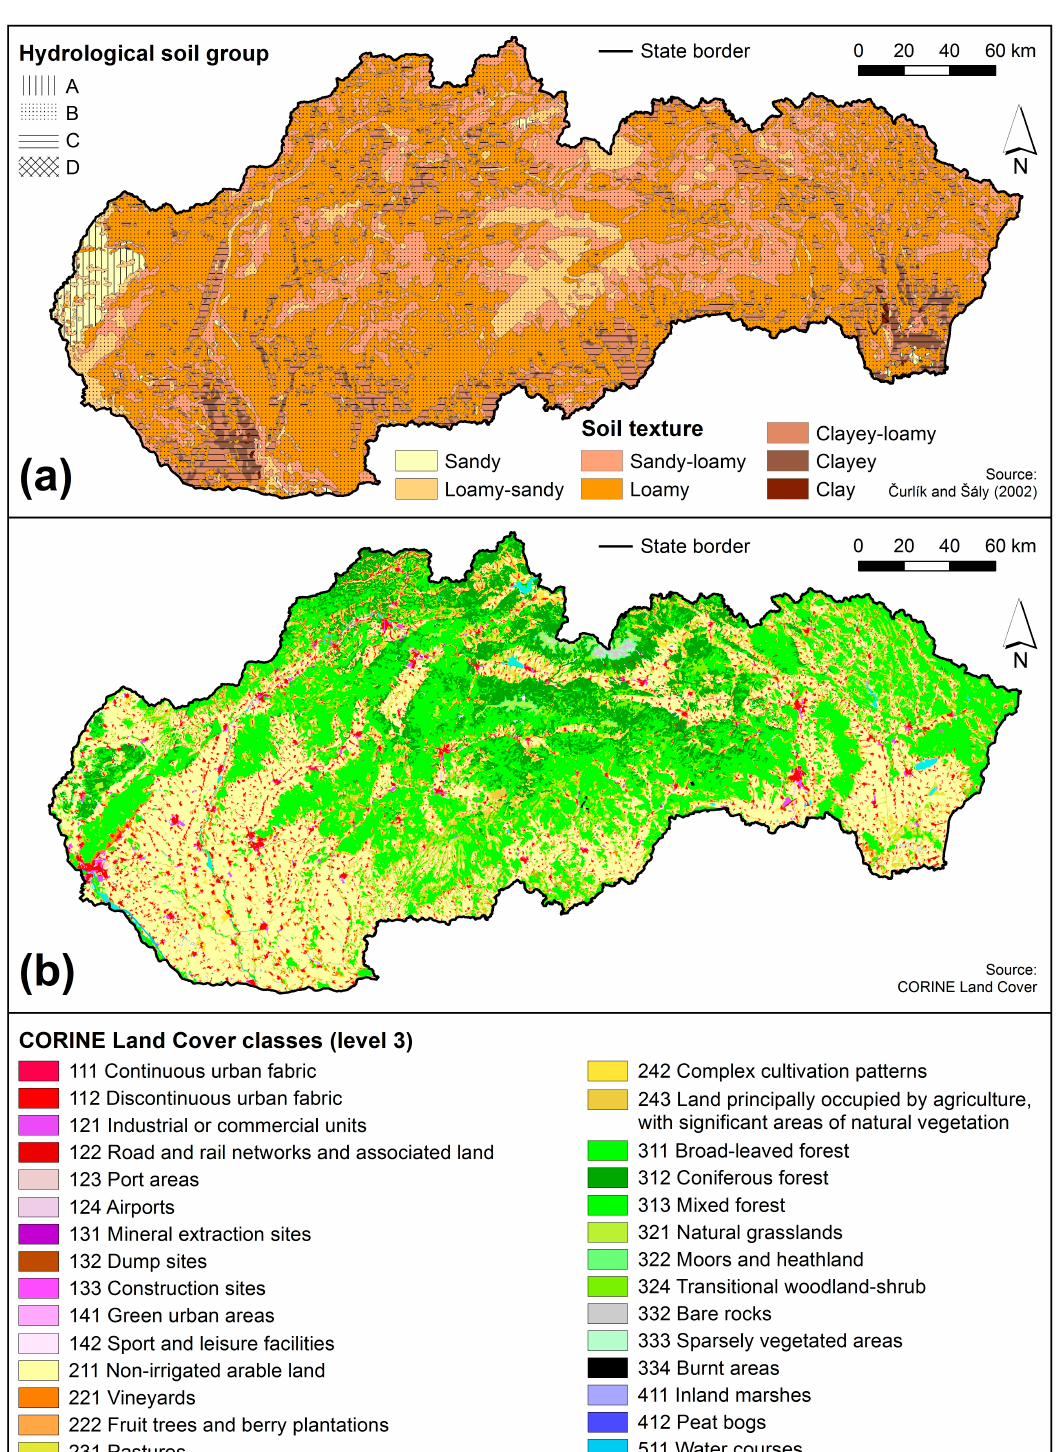
Figure 5. Soil texture and hydrological soil groups ( a ), CORINE land cover classes (2018) ( b ).